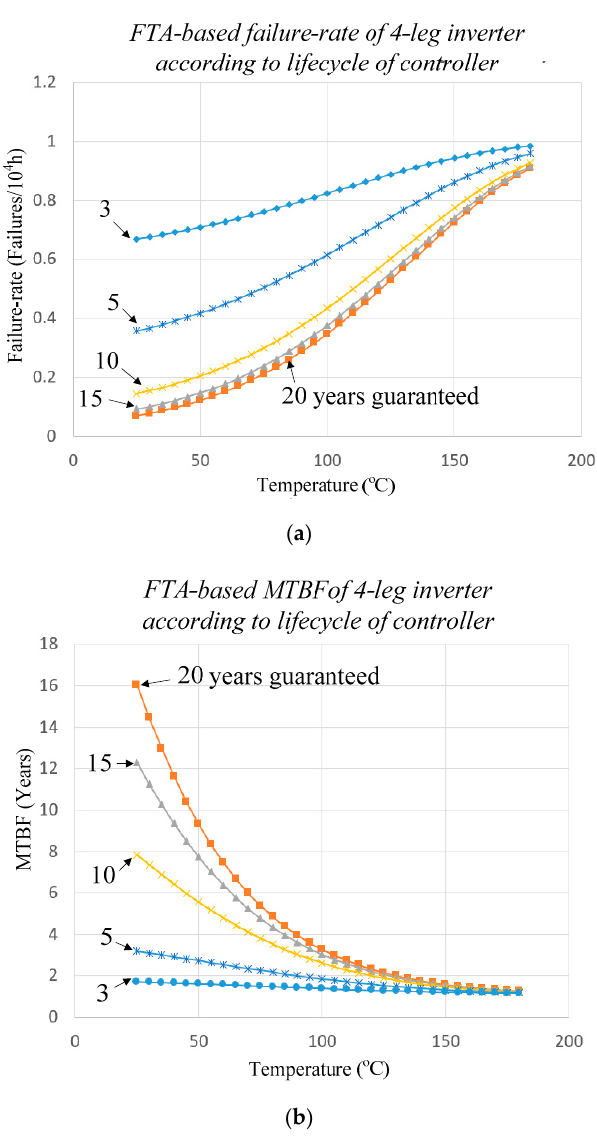
Figure 16. Failure rate and MTBF 4-leg inverter according to the controller lifecycle: ( a ) Failure rate; ( b ) mean time between failures, year.